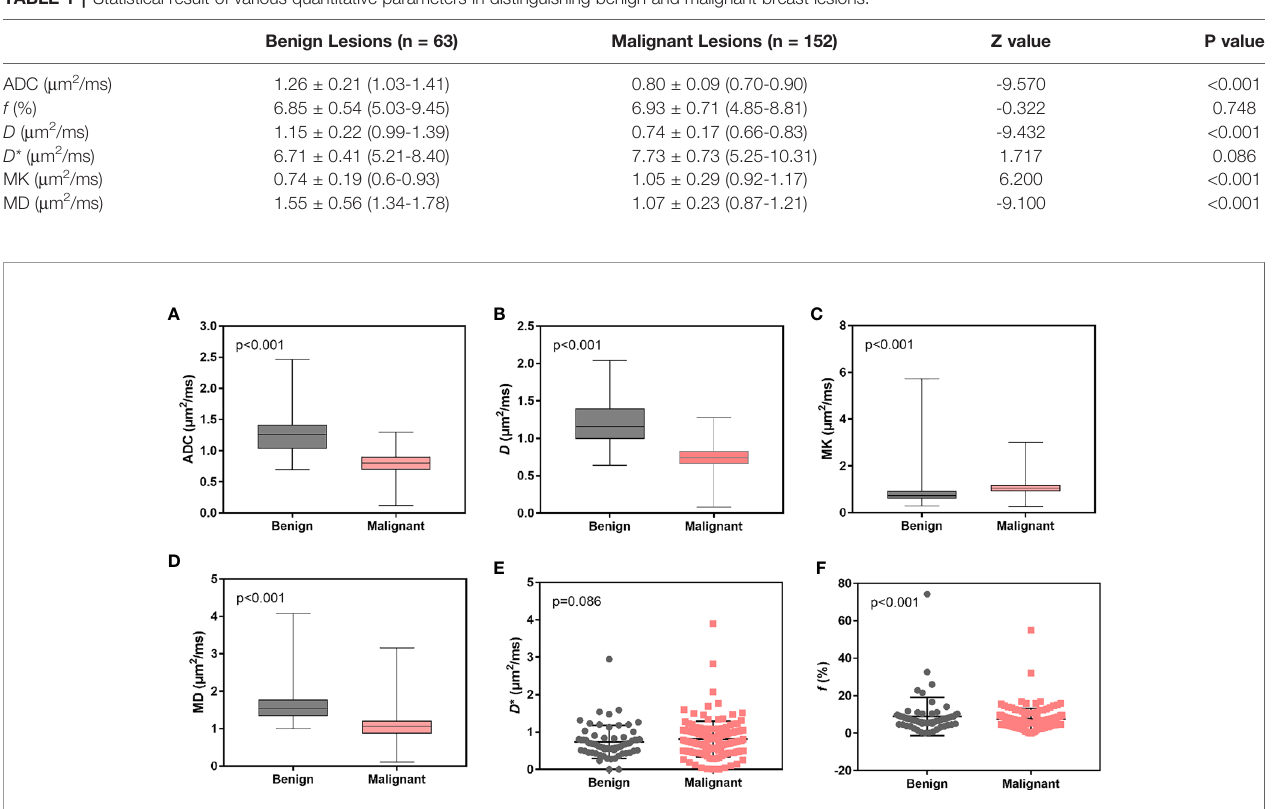
FIGURE 2 | Box and scatter plots for the average distribution of ADC, D , MK, MD, D* , and f of benign vs. malignant breast lesions. (A – D) Average value of ADC, D , MK and MD. (E, F) Average values of D* and f